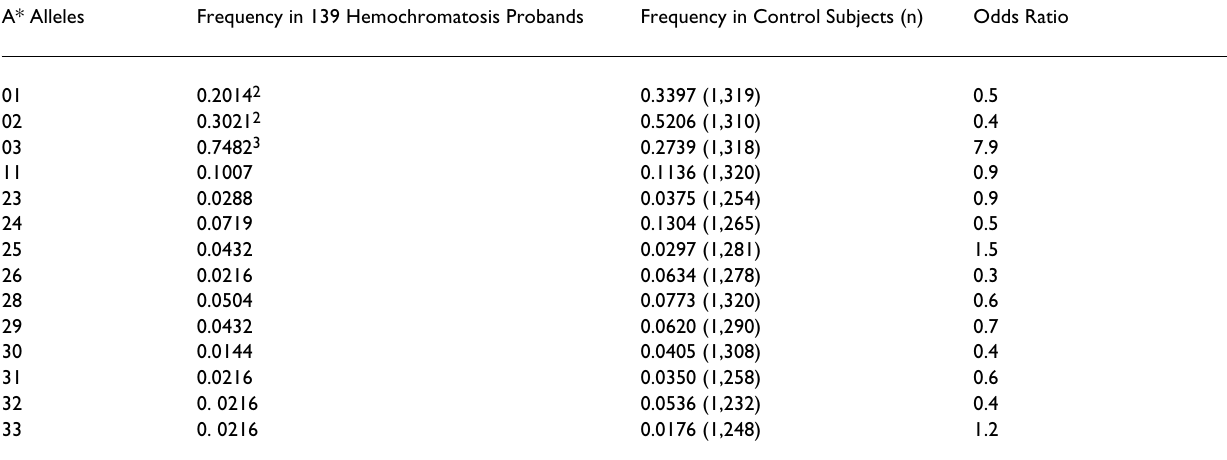
Table 1: Phenotype Frequencies of HLA-A Alleles in Alabama Subjects. 1 A* Alleles Frequency in 139 Hemochromatosis